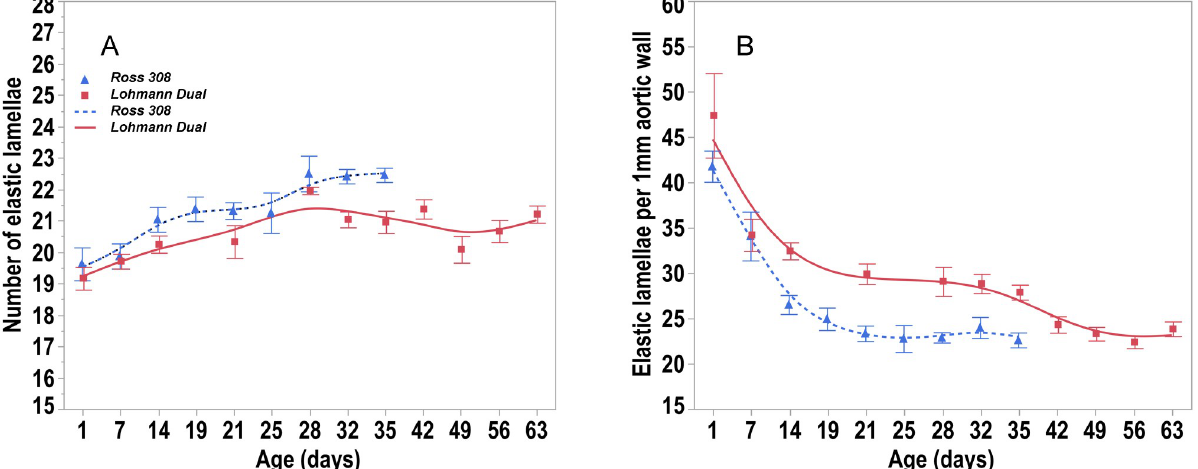
Fig 8. Trendlines of the changes in number of elastic lamellae versus day post hatching. (A) number of elastic lamellae and (B) number of elastic lamellae per 1mm aortic wall versus days post hatching for Ross and LD chicken lines. Bars refer to mean ± standard error of the mean of the chicken samples at each time